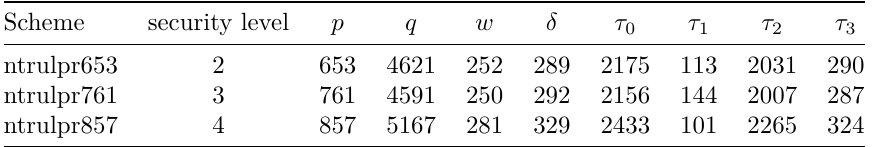
Table 2: Parameter sets of NTRU LPRime.